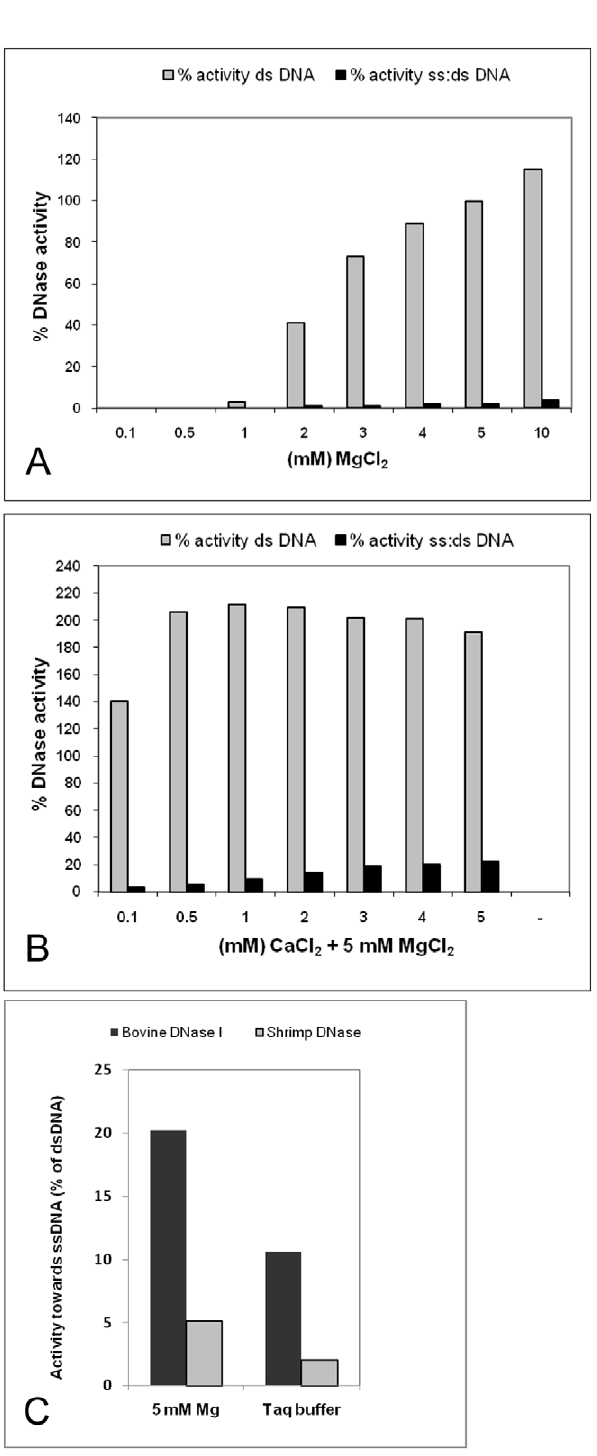
Figure 4. Nuclease activity and specificity against ss- and dsDNA. Relative activity of Northern shrimp nuclease on double stranded (ds) and heat denatured (ss) DNA as a function of divalent cations ( A : magnesium alone, B : magnesium plus calsium) using the modified Kunitz assay. One hundred percent activity was set using dsDNA substrate at 5 mM MgCl 2 . The ss nuclease-activity represents the relative activity on heat-denatured when compared to native ds calf thymus DNA. C displays relative activities of bovine pancreatic DNase I and P. borealis dsDNase on ssDNA in the described assay buffer or in a conventional Taq-buffer.